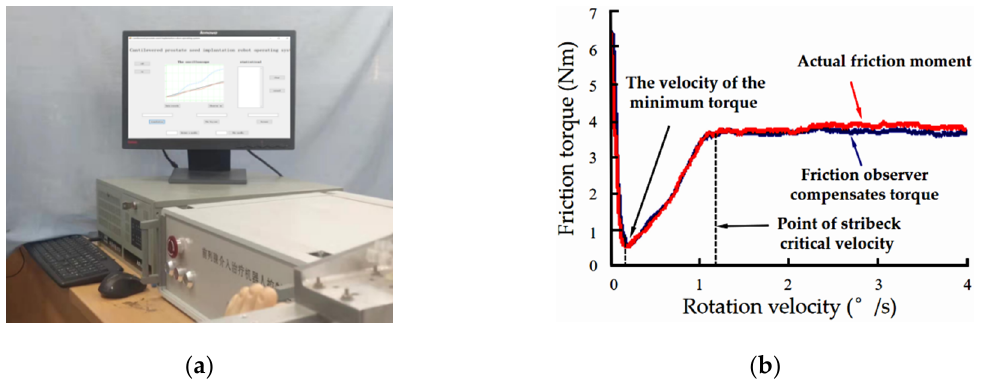
Figure 11. Diagram of control system and test friction. ( a ) Diagram of the controller system, ( b ) Test diagram of the friction torque.